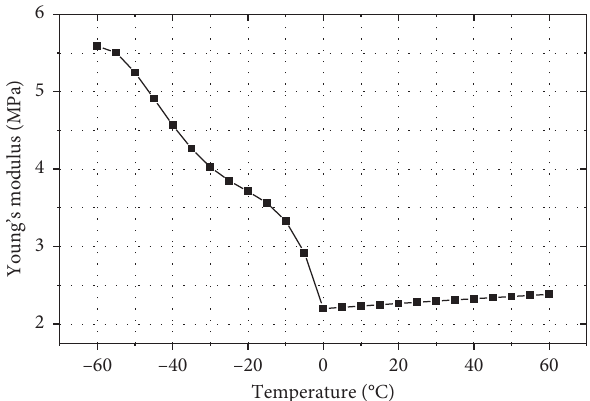
Figure 4: The relationship between Young’s modulus and tem- perature of rubber